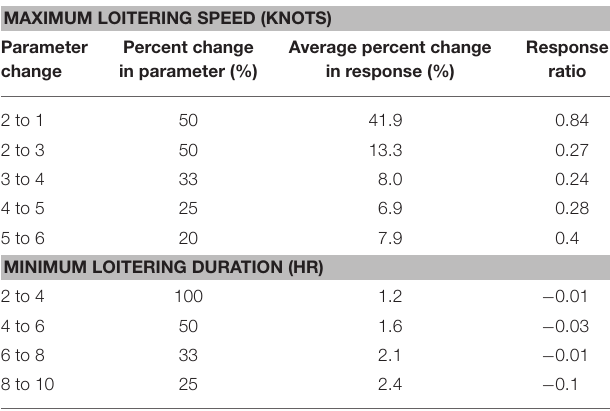
TABLE 1 | Sensitivity analysis for encounters, identifying the sensitivity of total encounter hours to changes in three parameters (minimum encounter duration, maximum encounter speed, and maximum intervessel distance) used to detect encounters.